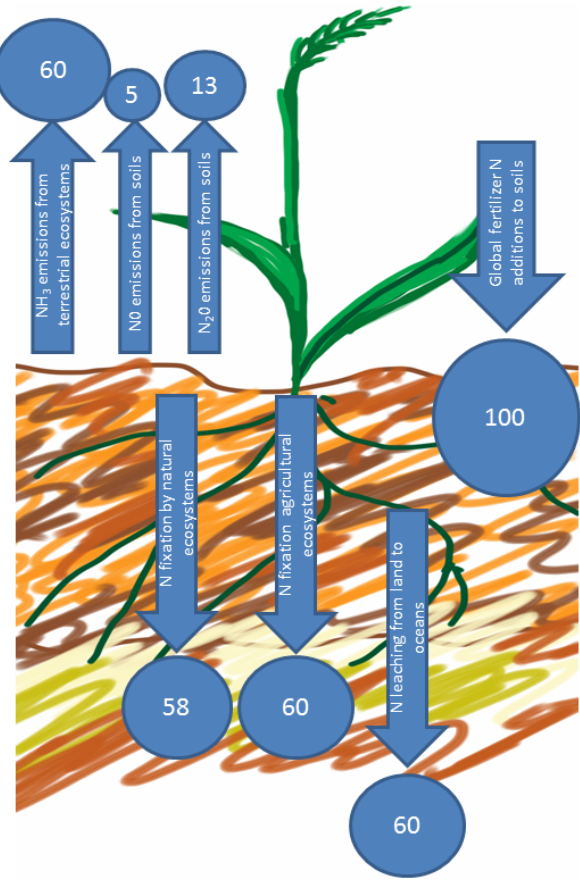
Figure 1. Global fluxes of N thorough soils (TgNyr − 1 ) . Based on data from Fowler et al.